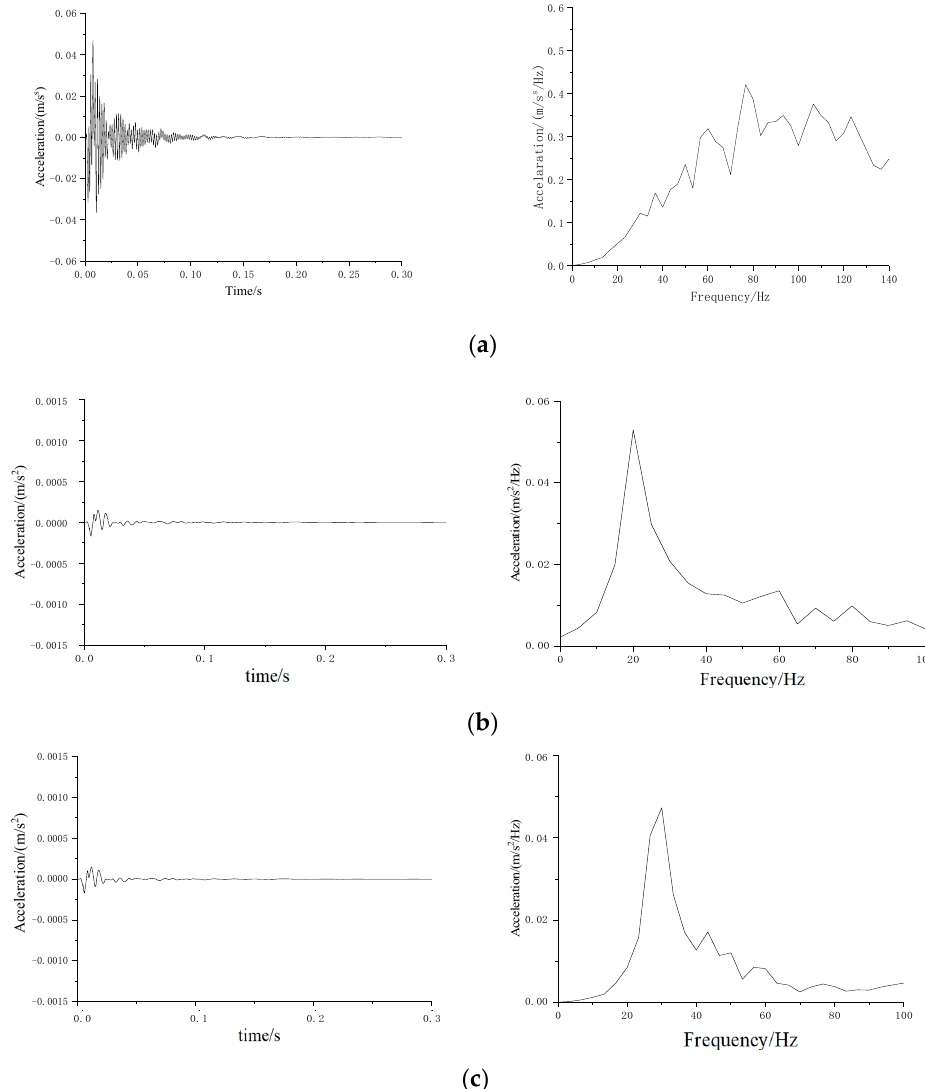
Figure 13. Time history and Fourier spectrum of calculated acceleration responses. ( a ) Regular slab track without mat; ( b ) FST with mat using Kelvin’s model; ( c ) FST with mat using 3PVM.